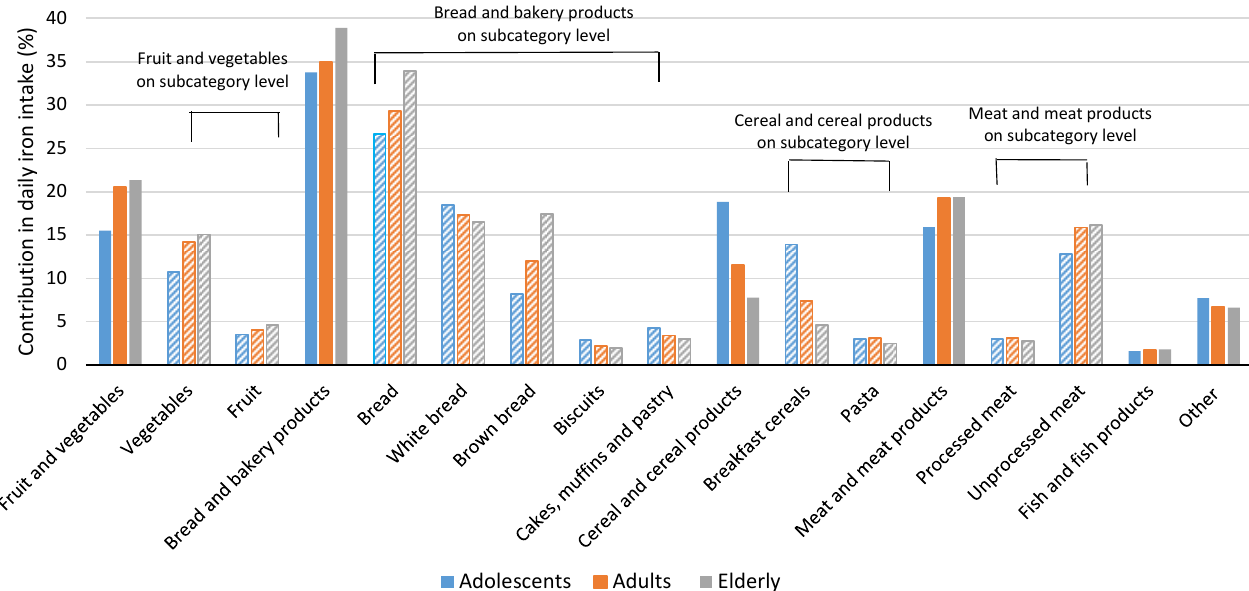
Figure 2. Relative contribution of selected food categories (bars with solid pattern) and subcategories (bars with lined pattern) to usual daily dietary iron intake among adolescents, adults, and elderly (% of total iron intake).